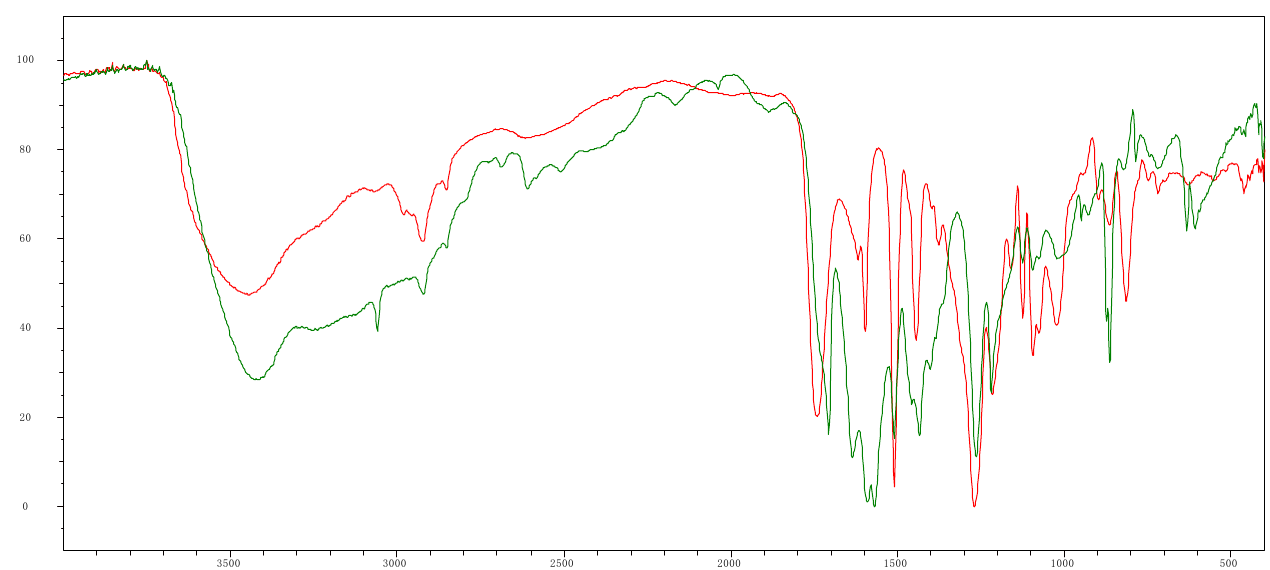
Figure A1. FTIR spectra of type I (red line) and II (green line) polymers based on 3-(3,4-dihydroxyphenyl) glyceric